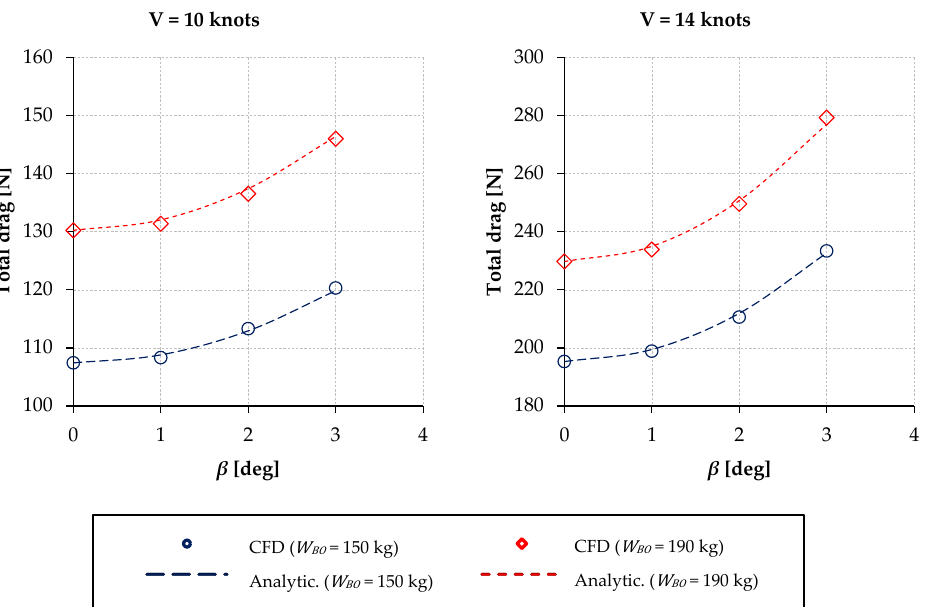
Figure 8. Hull resistance increase due to leeway angle for the reference demihull. The analytical formulations can be tuned to model new hulls knowing a total of three CAD measurements at three displacements and a minimum of six CFD solutions or experimental forces measurements at two values of velocities, attitudes and leeway angles. The coefficients adopted to model the reference Flyer S demihull forces are listed in Table